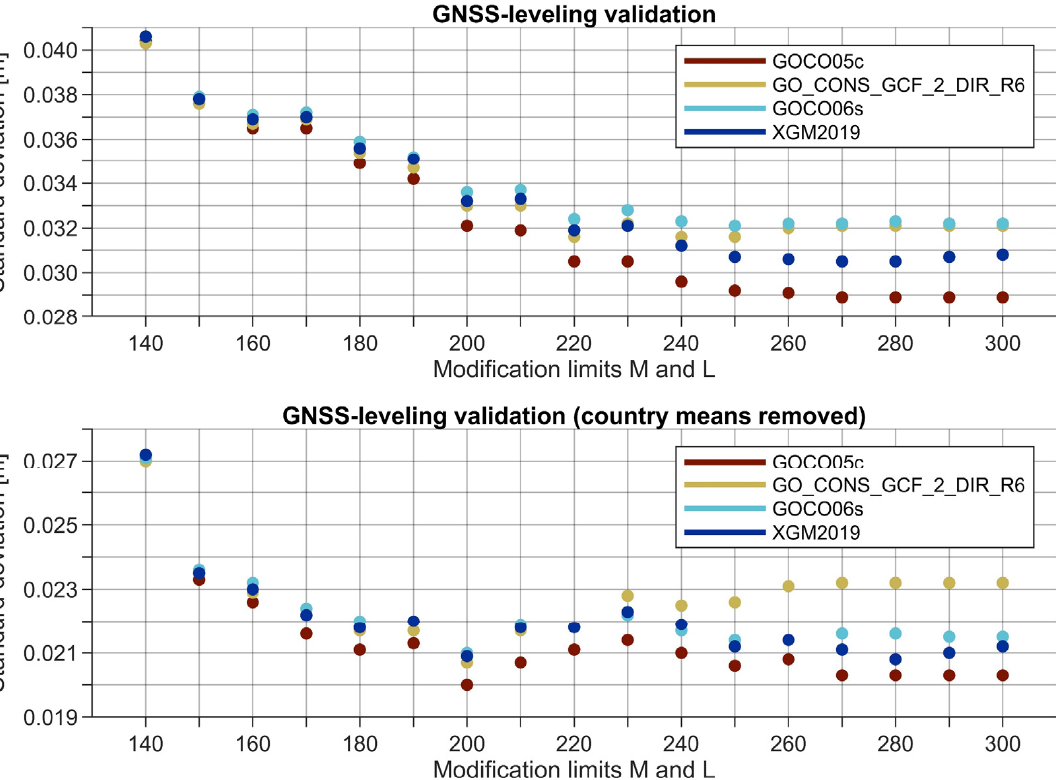
Figure 12. Validation results of gravimetric geoid models using GNSS-leveling control